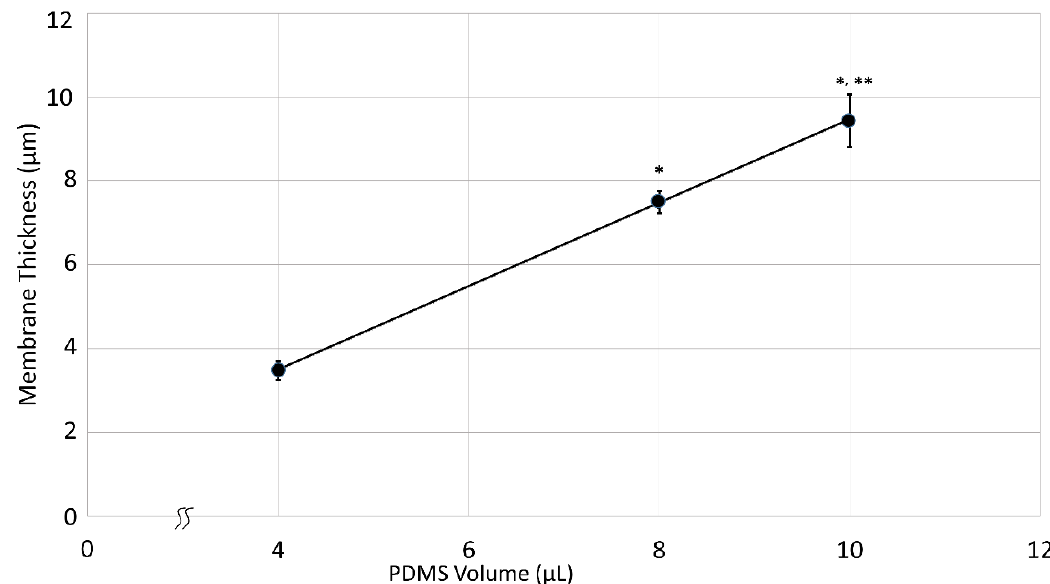
Figure 4 . PDMS membrane thickness as a function of PDMS volume. Averages and standard deviations of all groups ( n = 11 per group) are shown including the regression line. All groups showed a significant difference between each other within a 99% confidence interval (* p < 0.01 vs. 4 µL group, ** p < 0.01 vs. 8 µL group). r 2 = 0.97.